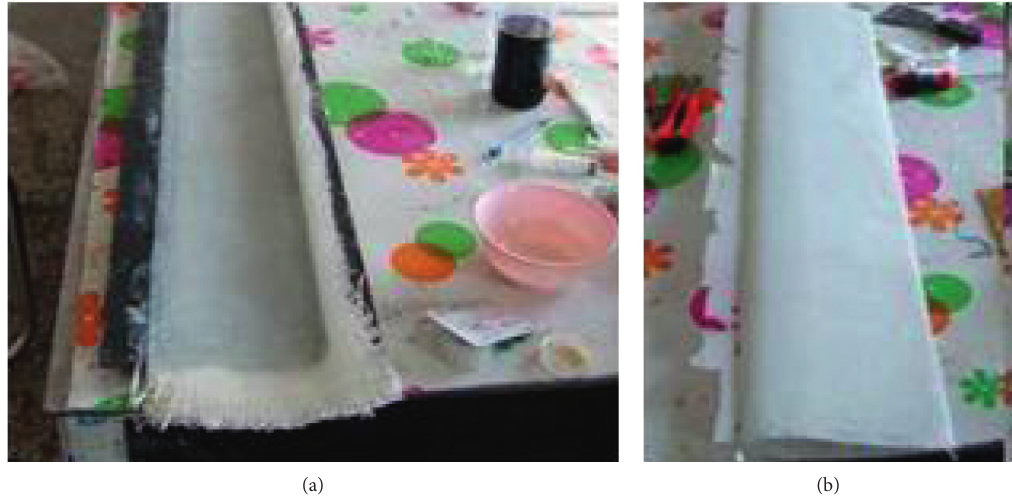
Figure 4: Airfoil surface forming. (a) Fiberglass layup. (b) Finished airfoil with excess